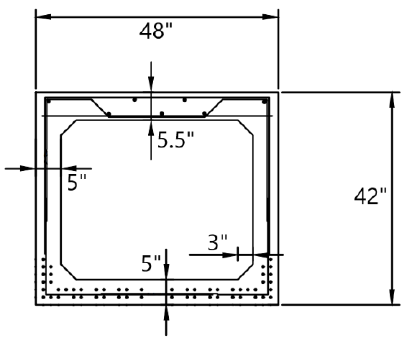
Figure 1. Upstream view of the 55-3014-0050-0509 bridge (Somerset bridge). Figure adapted from PennDOT bridge inspection 2014.